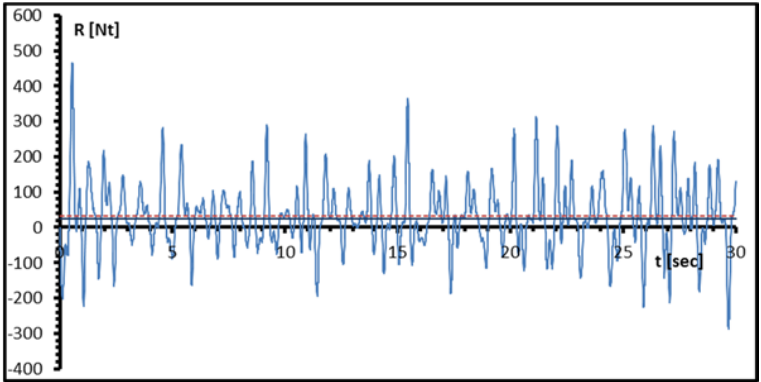
Figure 13. Resistance time series for Experiment #1.